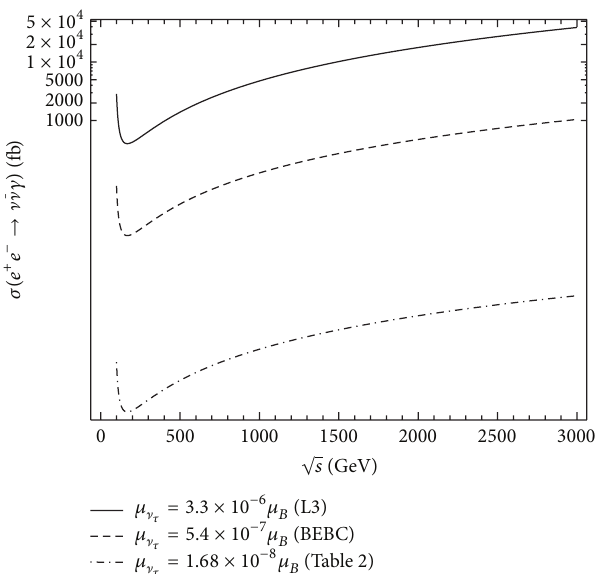
Figure 3: The curves show the shape for 𝑒 + 𝑒 − → ]] 𝛾 as a function of center of mass energy and different values of the 𝜇 ]